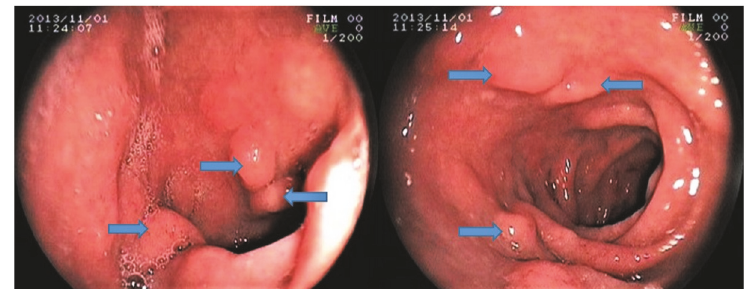
Figure 1: Brunner’s gland hamartoma in the duodenal bulb.